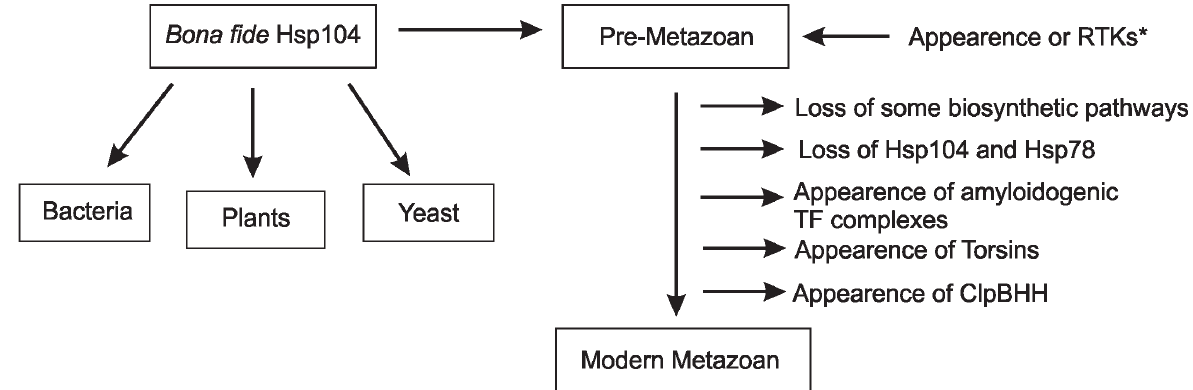
Figure 5 - Proposed Mechanism of Gene Loss and Gain in the Stem-metazoan Lineage as Applied to Disaggregase Activities. While Bona fide Hsp104 orthologs are highly conserved in bacteria, plants, yeast, and relatives of pre-metazoan containing receptor tyrosine kinases (RTKs), they are absent in modern metazoans. This may be due to a number of factors including loss of biosynthetic pathways requiring Hsp100s (Hsp104 and Hsp78), complex cell signaling involving amyloidogenic transcription factor (TF) complexes, and the specialization of hypothetical weak disaggregases with high specificities and localizations, such as the torsins in the endoplasmic reticulum (ER), and ClpBHH in the mitochondria. *RTKs = Receptor Tyrosine